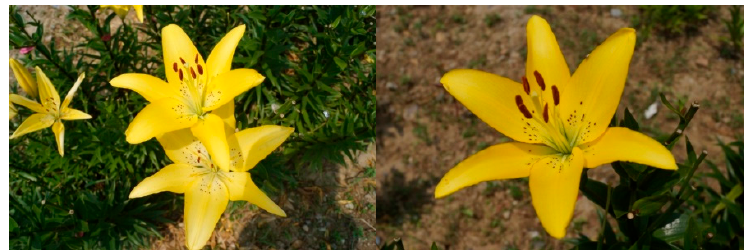
Figure 29. Experimental material.